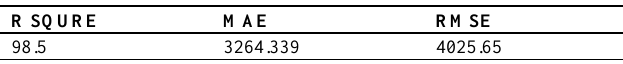
Table 10. The obtained error values in regression method using the factors in this work.